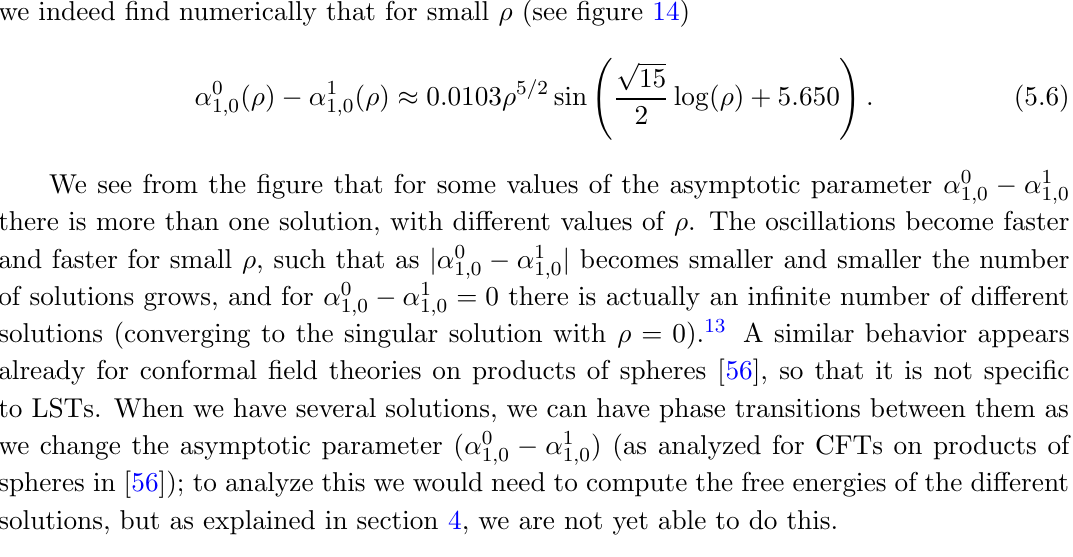
(cid:0) (cid:11) 1 , as a function of (cid:26) , to (5.6) for M = S 3 (cid:2) S 3 1 ; 0 1 ; 0